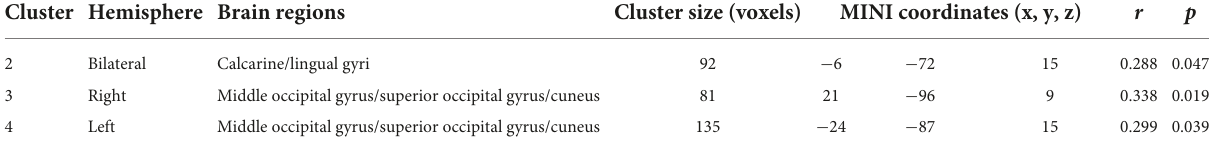
TABLE 4 The partial correlation analysis between the dALFF values and HAMD-SD scores in patients with melancholic MDD with high insomnia. Cluster Hemisphere Brain regions Cluster size (voxels) MINI coordinates (x, y, z) r p 1 Right Middle temporal gyrus/superior temporal gyrus 43 0.41